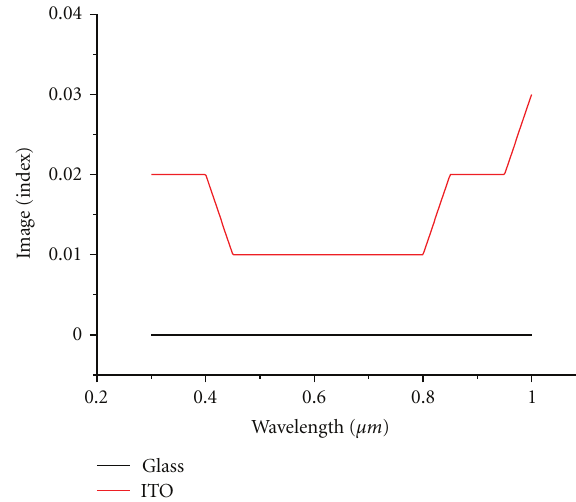
Figure 3: The imaginary part of the index as a function of wave- length. The solid red line shows the imaginary part of the index of ITO while the solid black line shows the imaginary part of the index of glass.